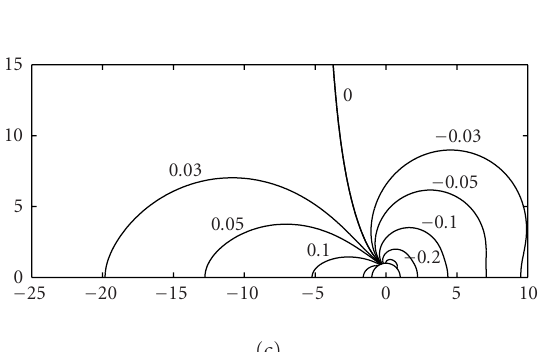
the experimental findings of Maxworthy [13], Yonas [23], and Josserand et al. [8]. The constant decrease of the base pressure for high N is the major source of the increase in the overall drag coe ffi cient C D . For these values of N , the loss in total pressure su ff ered along the front streamlines under the e ff ect of the j × B forces are responsible for the rear pressure drop. This behavior is responsible for the increase of pressure drag coe ffi cient which in turn increases total drag coe ffi